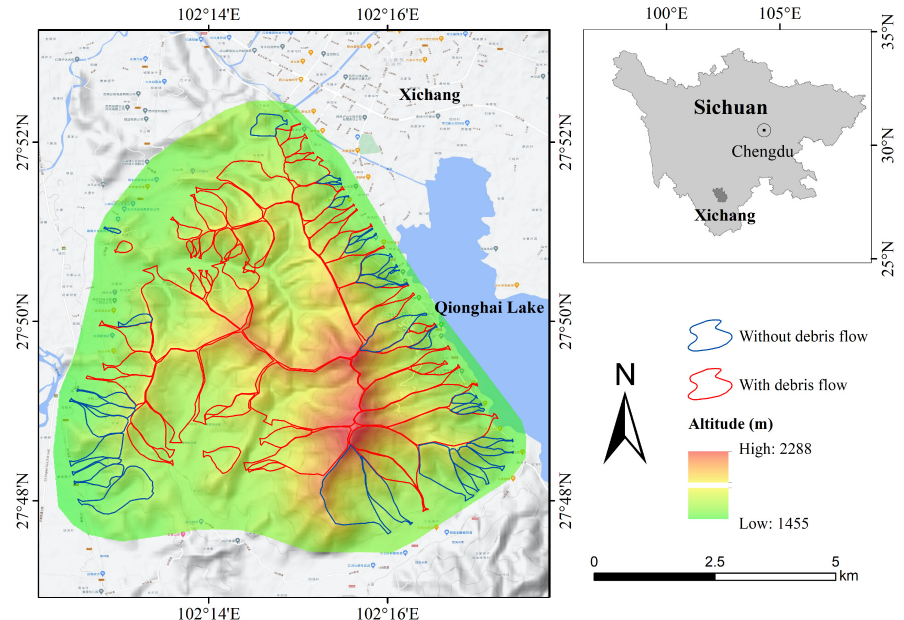
Figure 1. Location of the “30 March 2020” fire burned area and distribution of 82 burned watersheds in Xichang, in which the red line represents the watersheds with post-fire debris flow (greater than or equal to once) and the blue line represents the watersheds without post-fire debris flow (only floods), and the monitoring time is the first post-fire rainy season (May to October 2020).